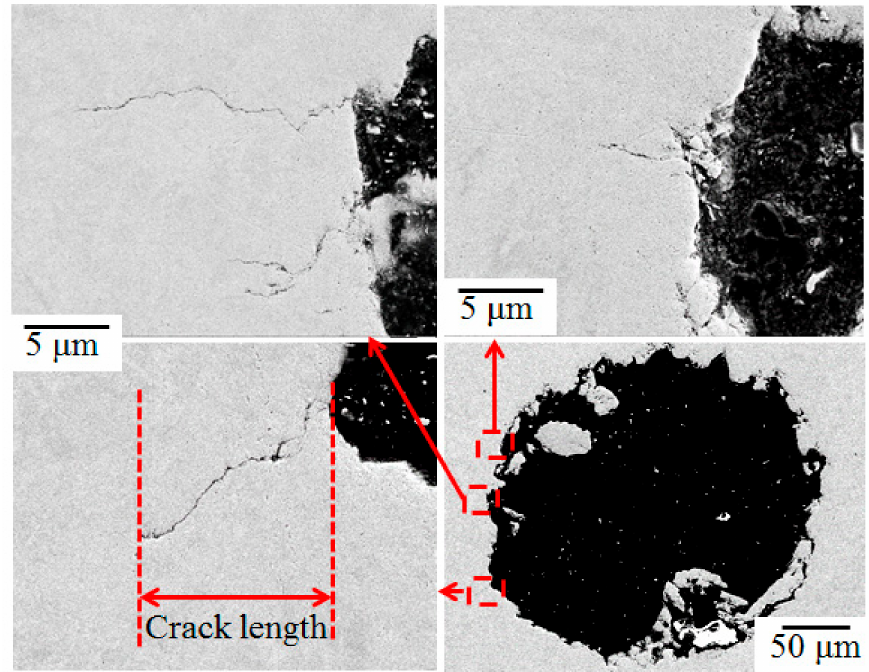
Figure 5. SEM images of fatigue microcracks emerging from a pit of 209 µ m depth in a 12Cr MSS. The layer removal method was used to characterise crack development as a function of distance from the surface; the cracks shown are after a layer removal of 51 µ m. Reprinted with permission from [16] Copyright 2017 Crown